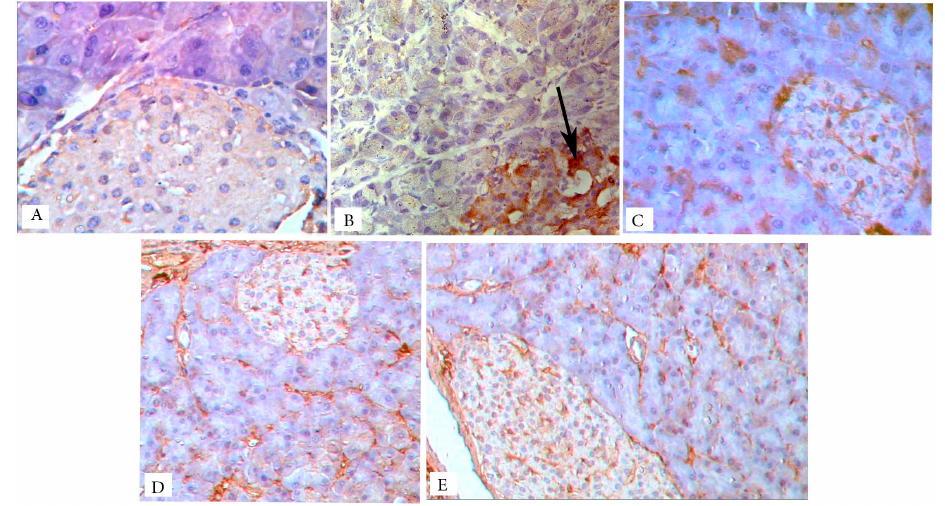
Figure 7. iNOS immunostained photomicrographs of pancreatic sections of the di ff erent studied groups. Arrows mark the brown coloration that is indicative of the positive cytoplasmic reaction. The control group ( A ) shows a negative reaction. The iNOS immunoreaction is limited to the islet cells of the untreated diabetic group ( B ), with no reaction detected in the pancreatic acini. All treated groups ( C – E ) show negative iNOS immunoreaction in both endocrine and exocrine pancreases. Magnification: ( A – C ) ×400, and ( D , E ) ×200.